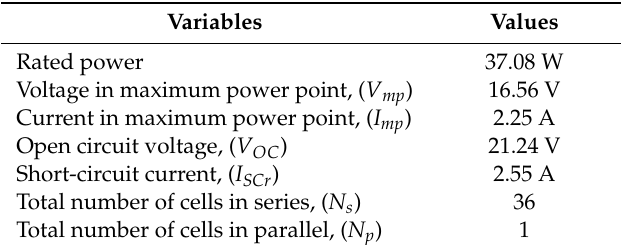
Table 4. Constants for the Photovoltaic cell.